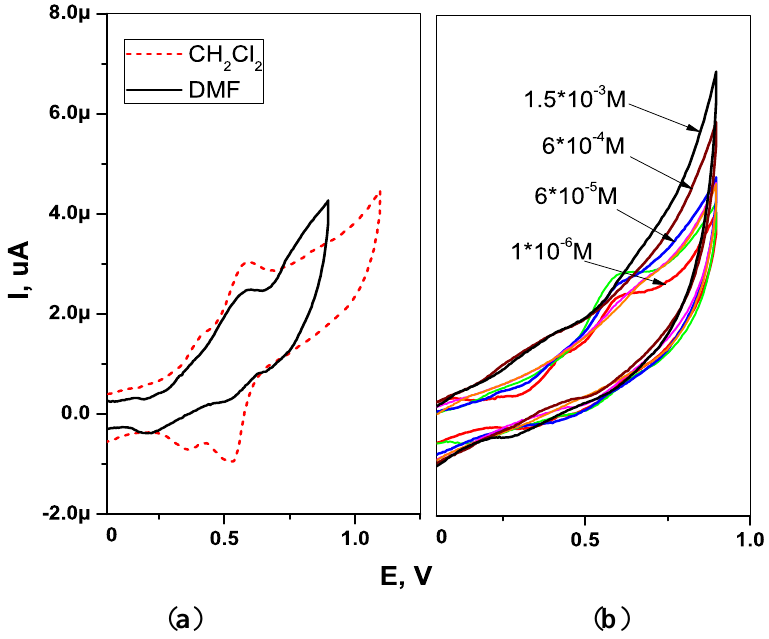
Figure 3. CVs of H exposure to growing concentrations of Pb 2+